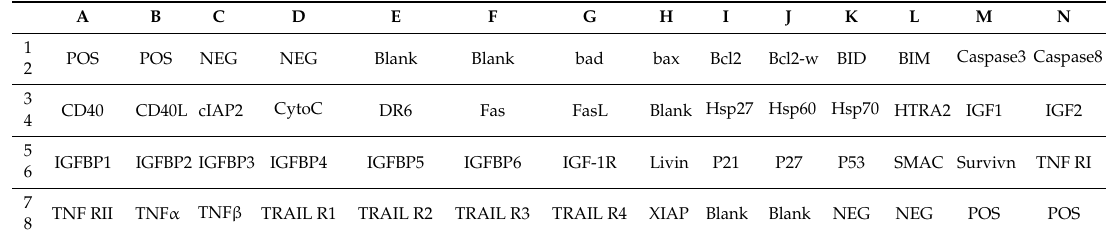
Table 2. The mini map of the Human Apoptosis Array C1 (according to RayBio ® manufacturer’s